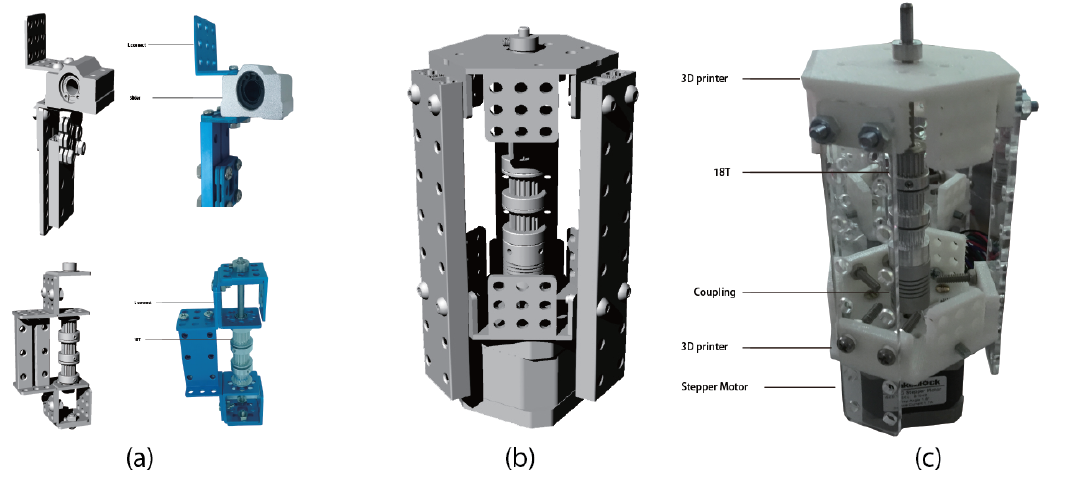
Figure 9. ( a ) Three subcomponents comprising connectors, motion bars and scissor truss configuration; ( b ) RCCE motion control unit; and ( c ) component assembly and